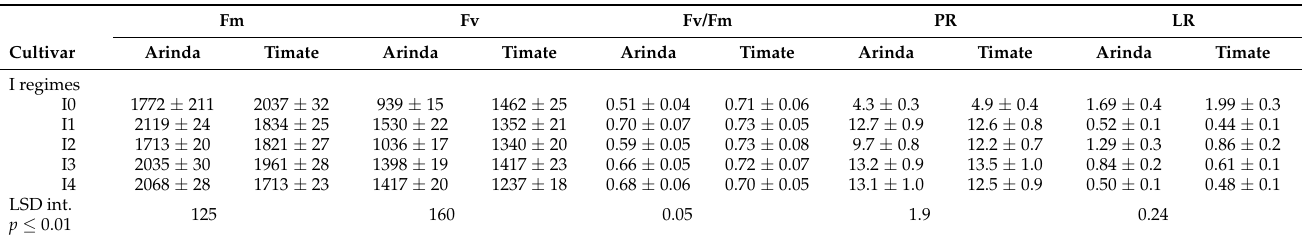
Table 3. Fm, Fv and Fv/Fm (Season II), Photosynthetic rate and Leaf resistance (Season I) as affected by the interaction “irrigation regime ×